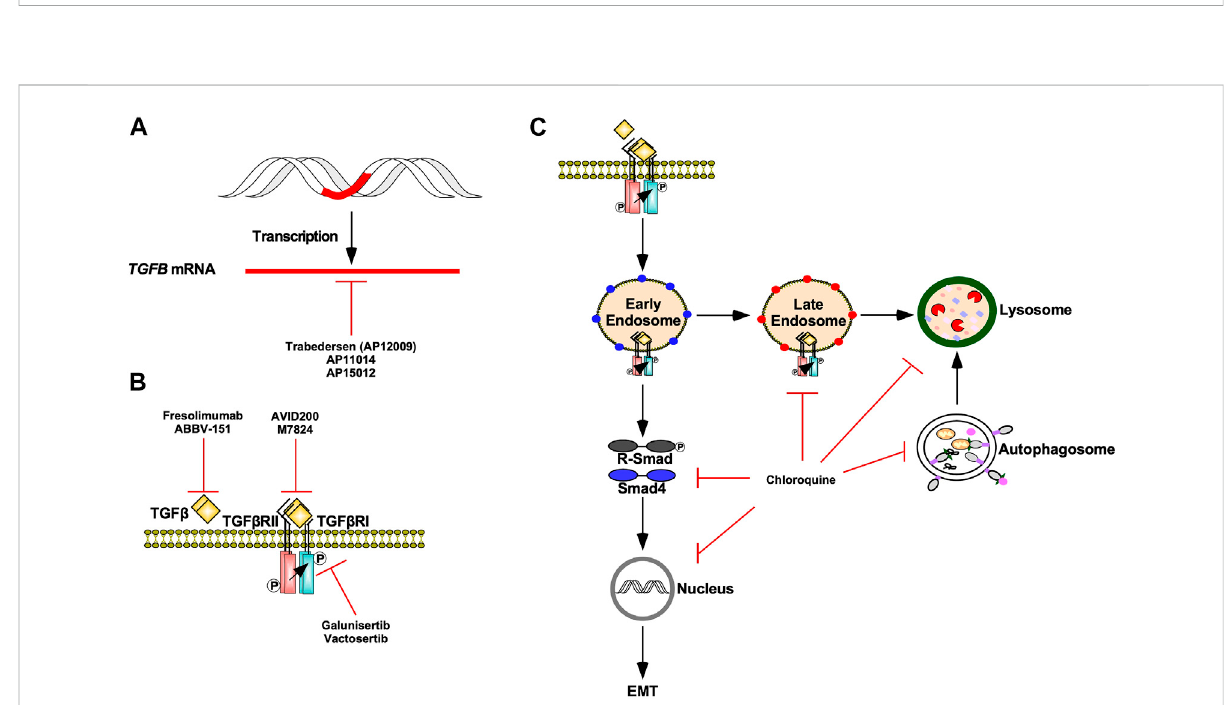
FIGURE 13 TGF β signallingtargetedtherapies. (A) Trabedersen(AP12009),AP11014,andAP15012areantisenseoligodeoxynucleotidesthatdecrease TGFB expression via mRNA targeting. (B) Fresolimumab and ABBV-151 are monoclonal antibodies against TGF β ligands that block TGF β from binding to TGF β receptor type II (TGF β RII). AVID200 and M7824 are ligand traps that compete with TGF β RII for TGF β ligands. Galunisertib and Vactosertib are TGF β receptor type I (TGF β RI) kinase antagonists. (C) Chloroquineis an autophagy inhibitor that blocks autophagosomes and endosomes from fusing with lysosomes as well as lysosomal-dependent degradation. Chloroquine impedes TGF β receptor internalization and traf fi cking through early endosome, late endosome, and lysosome membrane compartments. Chloroquine also decreases receptor regulated Smad (R-Smad) phosphorylation, R-Smad nuclear translocation, and TGF β -dependent epithelial-mesenchymal transition